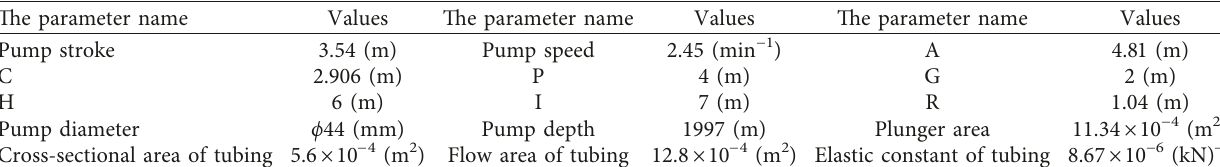
Table 2: Equipment parameters of pump unit, pump, and tubing.